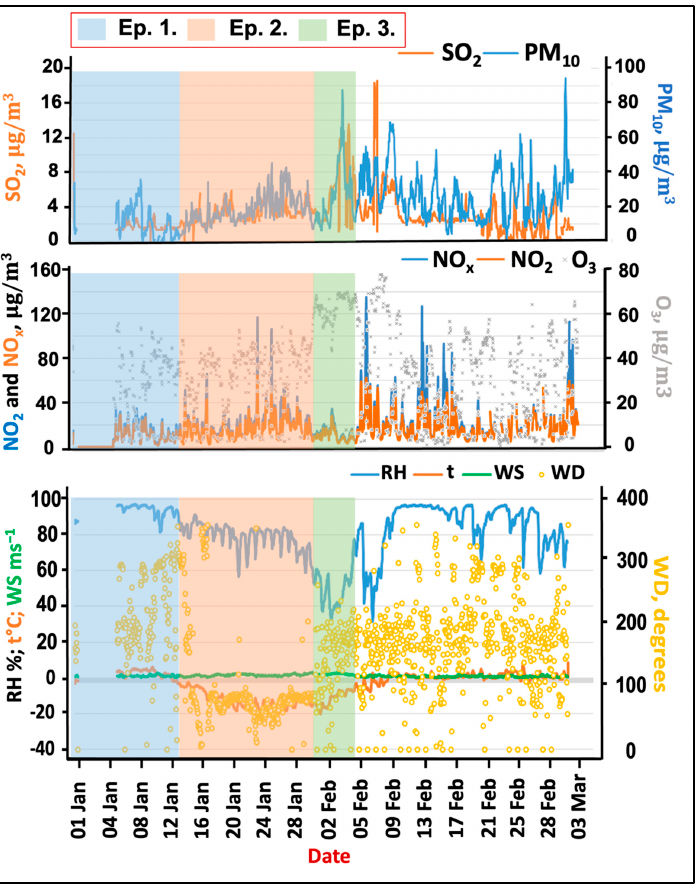
Figure 3. Time series of SO 2 , PM 10 , NO 2 , NO 3 , NO x , ambient temperature, wind direction (dots), wind speed, and humidity.